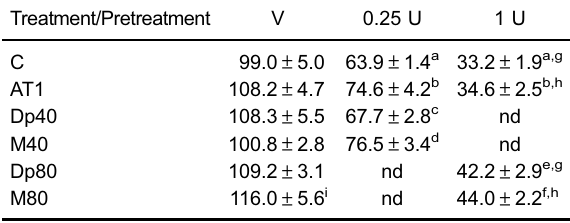
Table 2. Plasma glucose levels (mg/dL) of rats pretreated iv with saline (C), atropine sulfate (1 mg/kg AT1), dipyrone (40 mg/kg, Dp40; or 80 mg/kg, Dp80), or with a mixture of atropine (1 mg/kg) and dipyrone (M40=AT1 + Dp40 mixture, or M80=AT1 + Dp80 mixture) followed by the iv treatment with vehicle (V), 0.25 U or 1 U/kg insulin (0.25 U and 1 U,